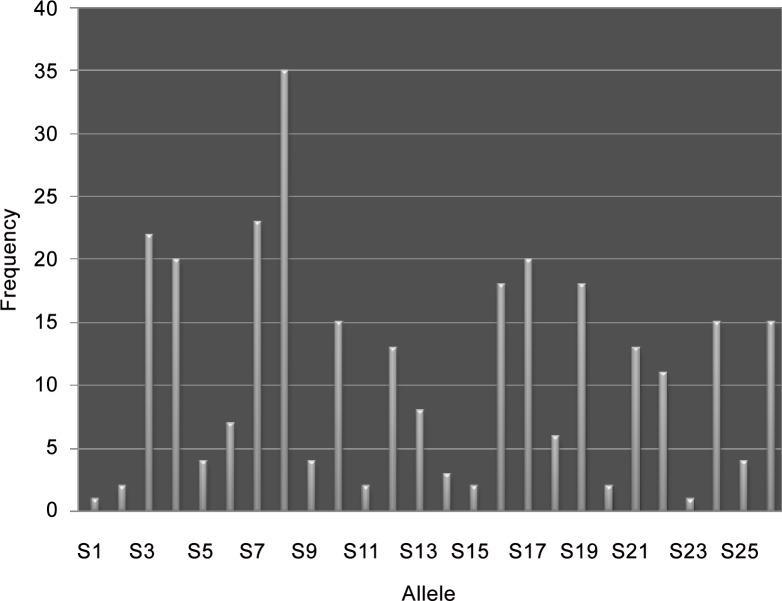
Graph indicating the frequencies of different S-alleles in P. africana